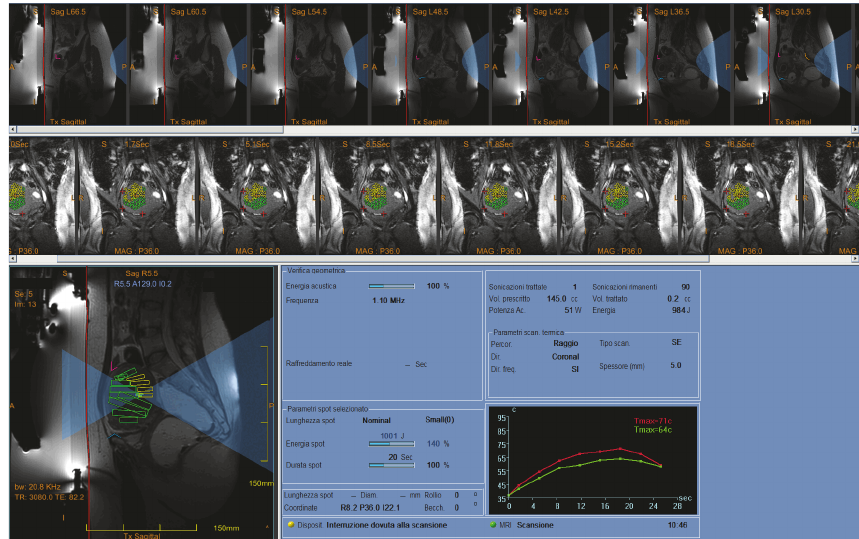
Figure 2: Screenshot from the ExAblate workstation showing the planned target of patient in case 3 after the first sonication performed. In bottom left, the HI-FU beam representation is shown in light blue, the red line indicates the skin-gel pad interface, and critical structures are secured by the use of specific low-energy density region (LEDR) and no-pass regions markers (bowel in pink, pubic bone in light blue). The target volume (region of treatment, ROT) has been split into multiple subvolumes (green and yellow voxels) each of which will be ablated by a specific sonication. Patients’ movements during treatment are monitored by reviewing fiducials (red crosshairs) placed by the treating physician on distinct anatomic structures which can be monitored during real-time MR imaging. Real-time thermal mapping after the first sonication is shown in the bottom right graph (maximum temperature achieved in the focal spot is 71 ∘